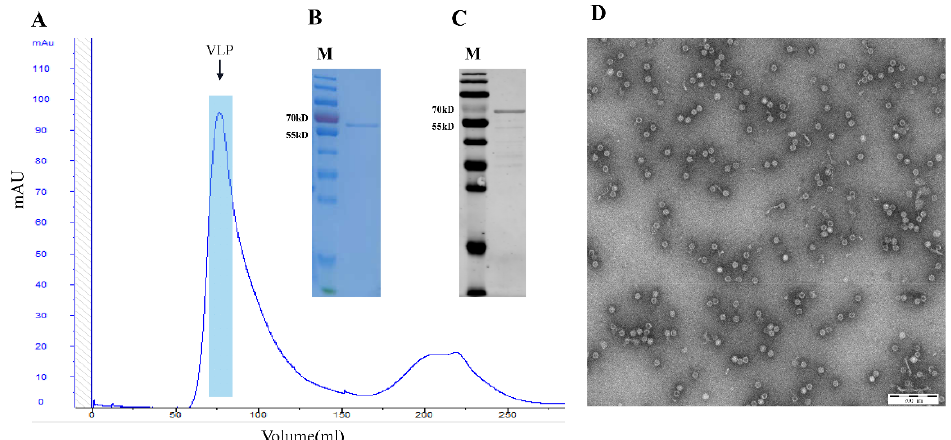
Figure 3. Analysis of PPV VP2 protein and PPV-VLPs after 2nd SEC purification. ( A ) SEC profile of PPV-VLPs. The peak represents properly-assembled PPV-VLPs. ( B ) Coomassie staining of the PPV VP2 proteins after 2nd SEC purification. ( C ) Western blot analysis of the more purified PPV VP2 proteins. ( D ) TEM image of the PPV-VLPs.